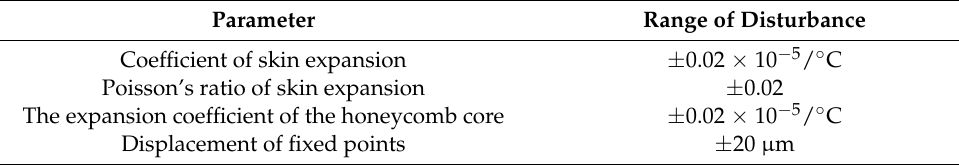
Table 7. Range of parameter